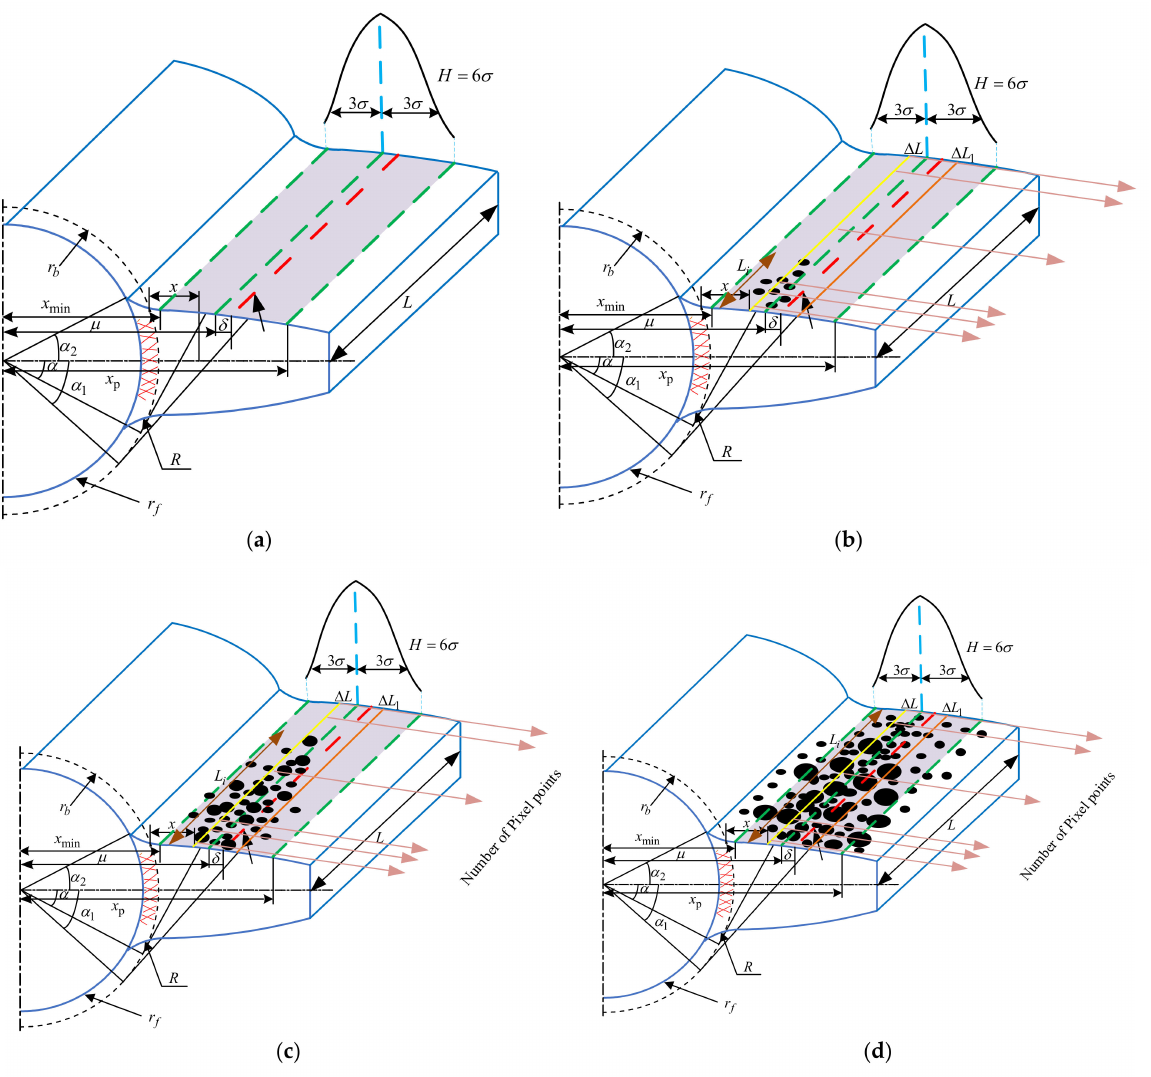
Figure 6. Pitting model: ( a ) Normal tooth; ( b ) Slight pitting of gear teeth; ( c ) Moderate pitting of gear teeth; ( d ) Severe pitting of gear teeth.